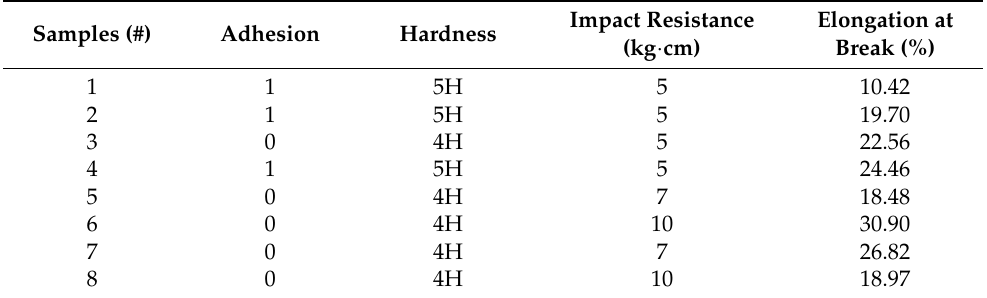
Table 5. Influence of coating processes on mechanical performances of waterborne coating containing microcapsules.